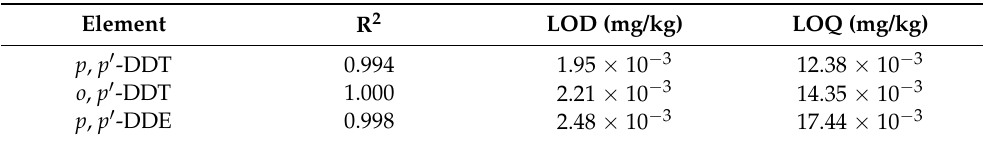
Table 2. Linear correlation coefficients (R 2 ), limits of detection (LOD) and limits of quantification (LOQ) for